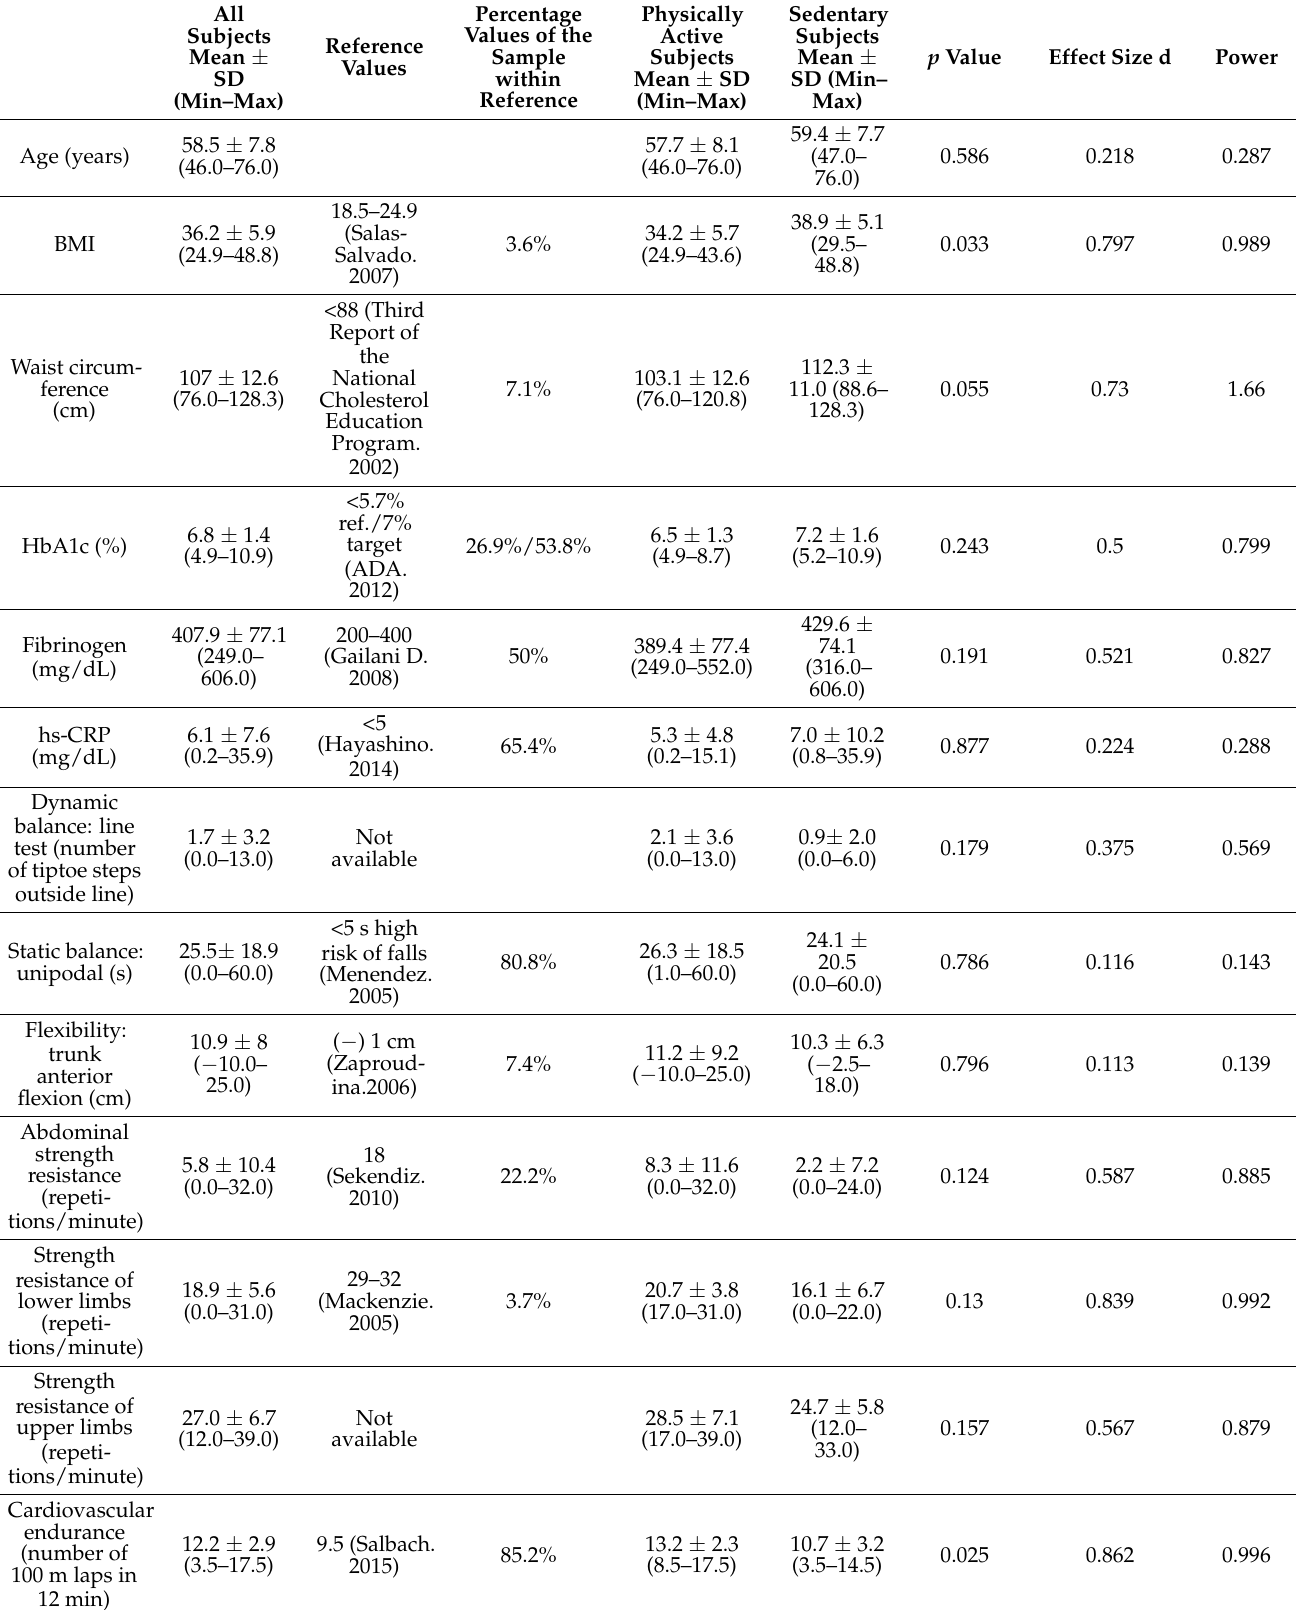
Table 1. Descriptive study and comparative analysis between physically active and sedentary